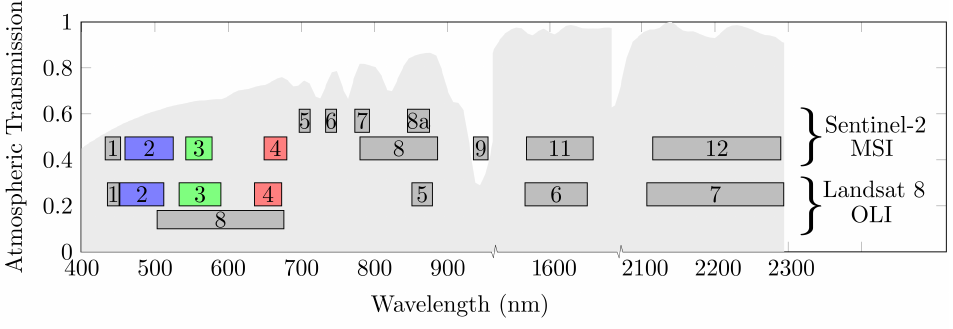
Figure 1. The placement of the Sentinel-2 and Landsat 8